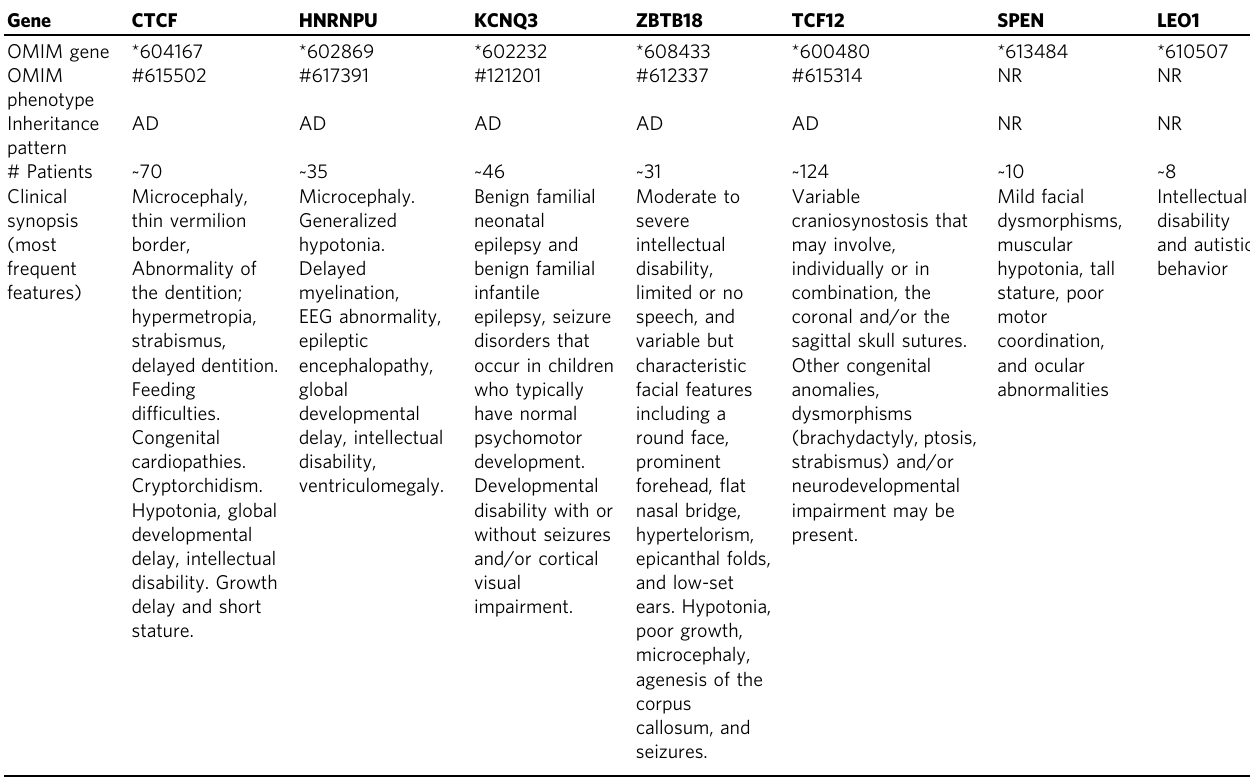
Table 3 Clinical recontact and detailed genotype – phenotype